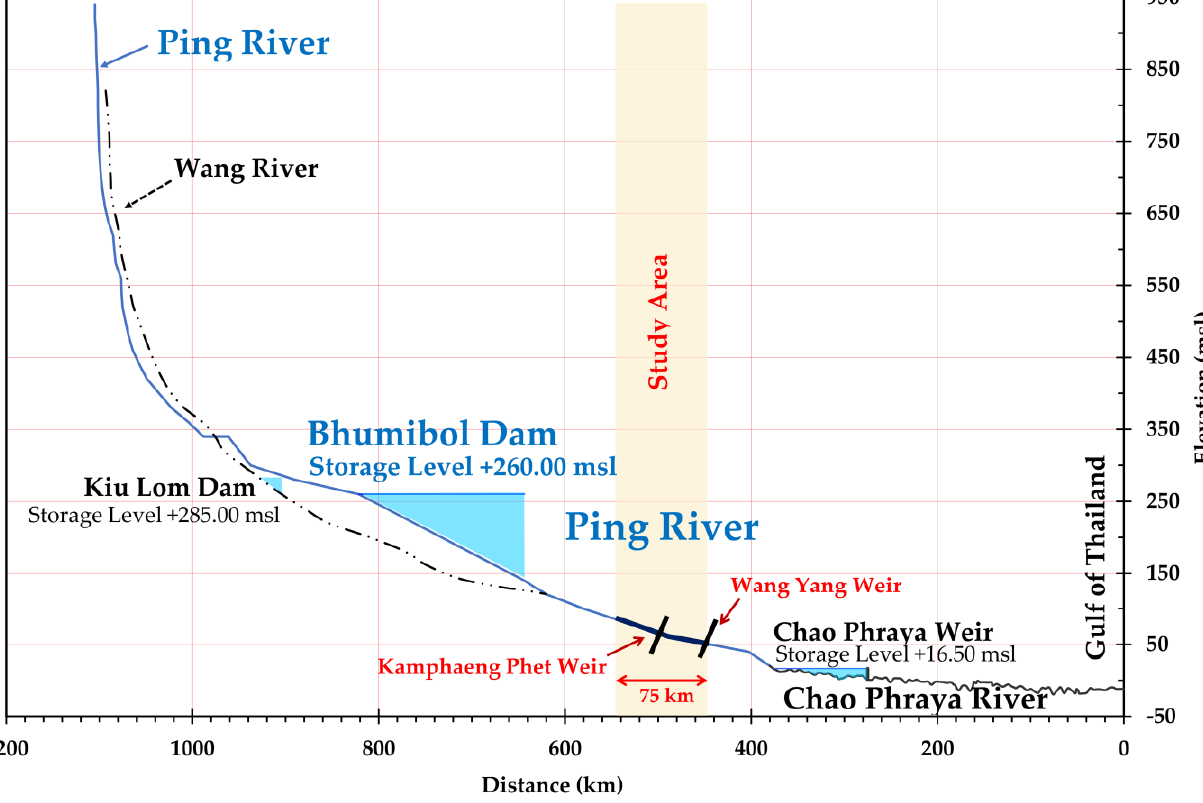
Figure 2. Ping River profile surveyed in 2019 by the Royal Irrigation Department.